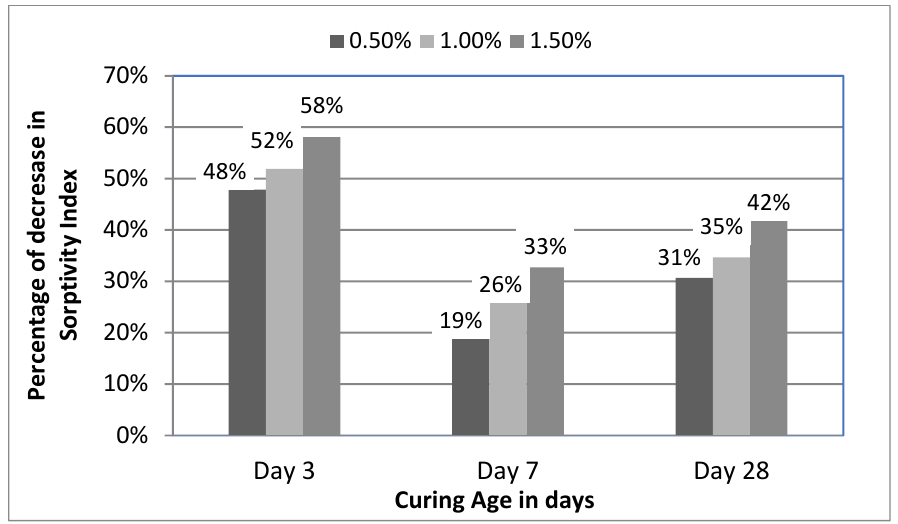
Figure 9. The effect of adding PA fibers on the percentage decrease in the sorptivity index of concrete mixes at 3, 7, and 28 days of curing.